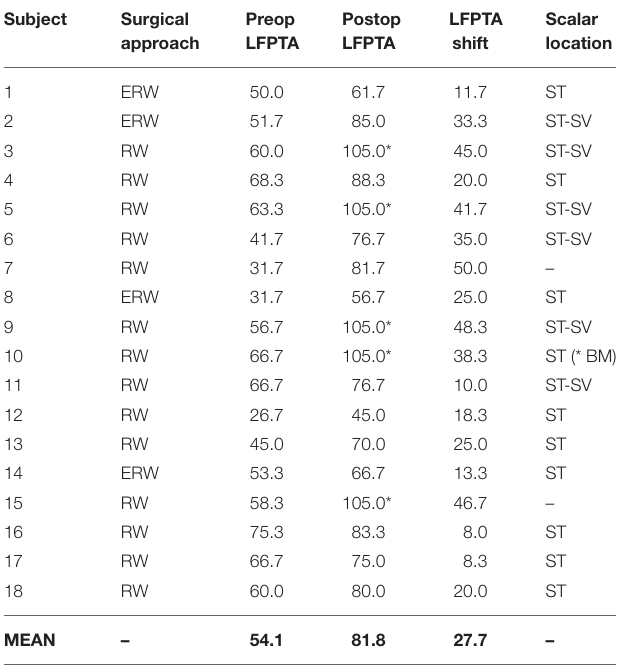
TABLE 1 | Subject demographics, RW, round window; ERW, extended round window; LFPTA, low frequency pure tone average (average threshold for 125, 250, and 500Hz, in dB HL); ST, scala tympani; SV, scala vestibuli; Preop, preoperative; Postop,